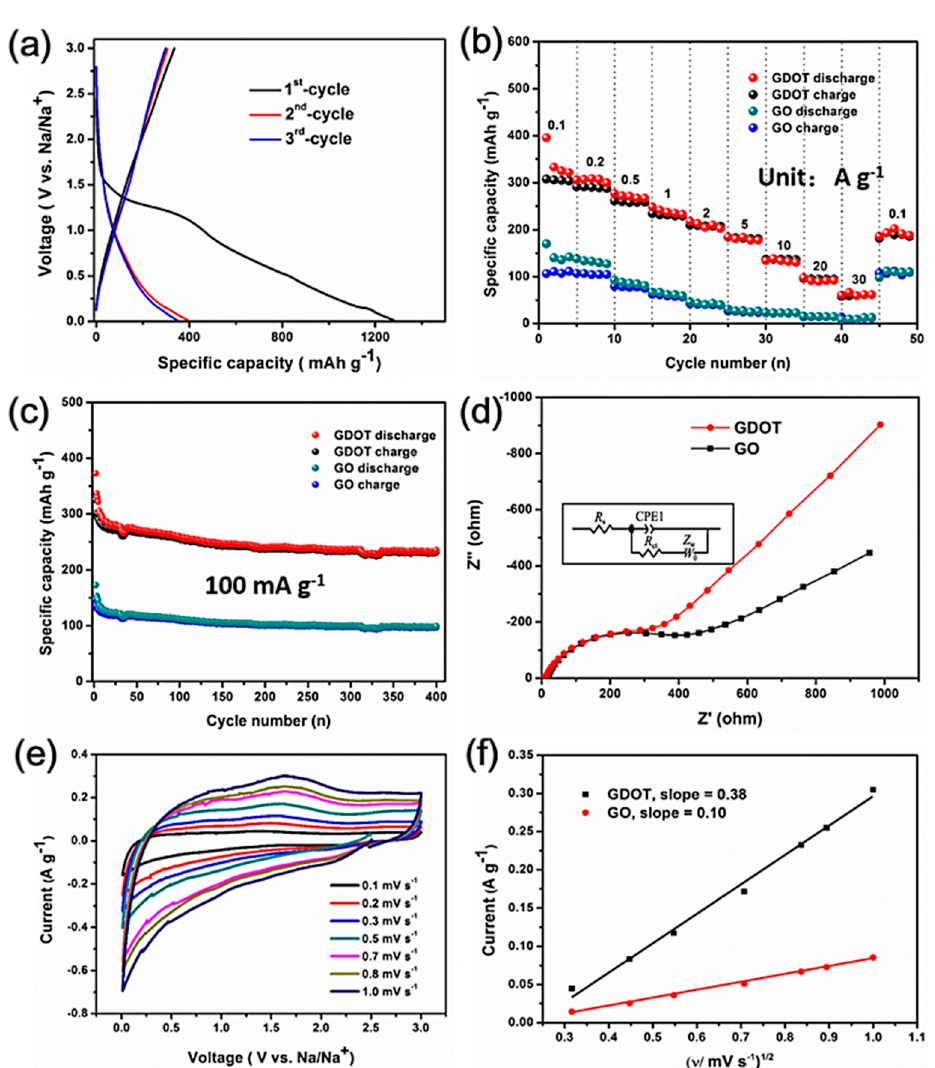
Figure 6. Electrochemical activity of GDOT and GO electrodes for SIBs: ( a ) The first three cycles discharge–charge curves of the GDOT electrode; ( b ) rate capability at different current densities from 0.1 to 30 A g − 1 ; ( c ) cycling performance at 0.1 A g − 1 ; ( d ) the electrochemical impedance spectra measurements (inset: fitted equivalent circuit); ( e ) CV curves of GDOT electrode at different scan rates from 0.1 to 1.0 mV s − 1 ; and ( f ) linear relationship of the cathodic peak current (i p ) and the square root of scan rate ( ν 1/2 ).